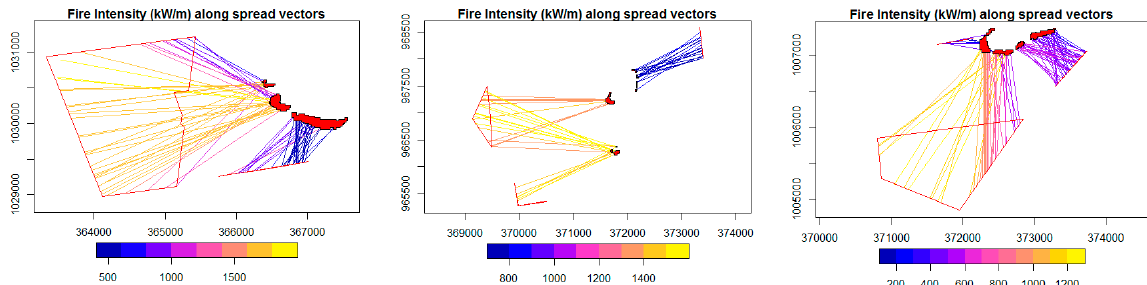
Figure 5. Color coded fire intensities (kW/m) derived for the fire fronts of Figures 1 and 2 (for further details refer to Figure 2).